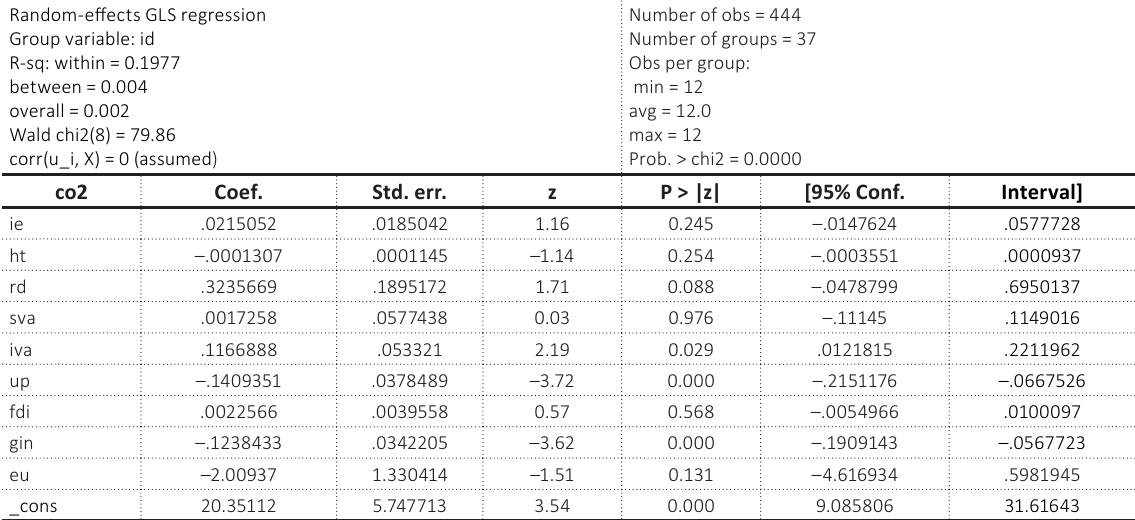
Source: Authors’ calculations performed using Stata 16.0.